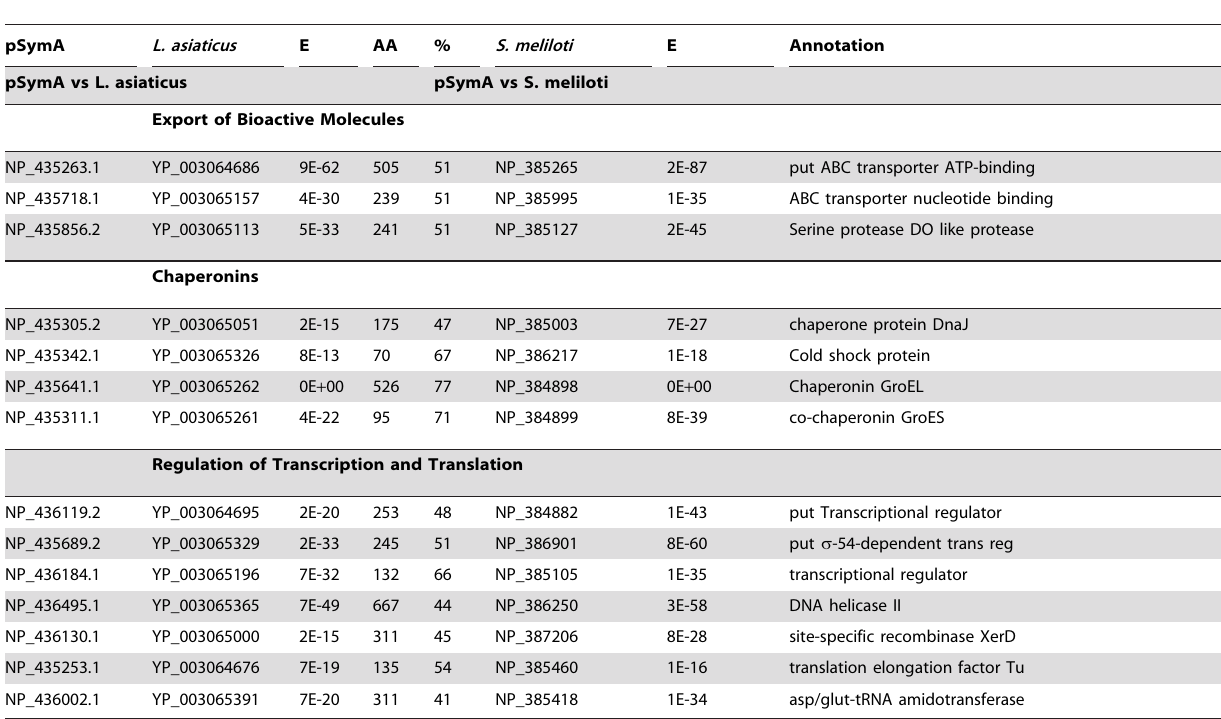
Table 3. Proteins shared between the Sinorhizobium meliloti plasmid pSymA, and the ‘ Ca . Liberibacter asiaticus’ and Sinorhizobium meliloti chromosomes with roles in the export of bioactive molecules, as chaperonins and in the regulation of transcription and